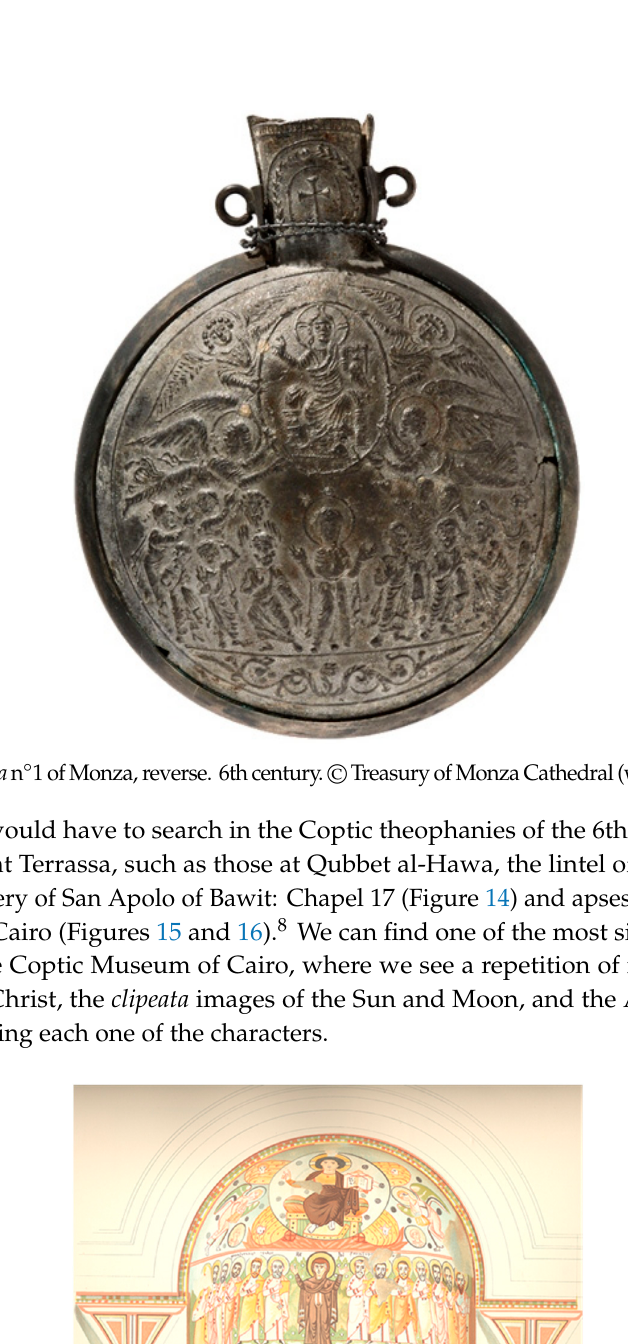
Figure 12. Rabbula Gospels from the 6th century (Florence, Laur., Plut. 1. 56, c.13v). © Biblioteca Medicea Laurenziana (with kind permission).